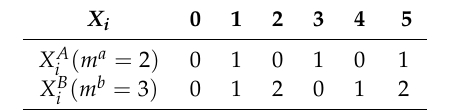
Table 1. An example of splitting based on the